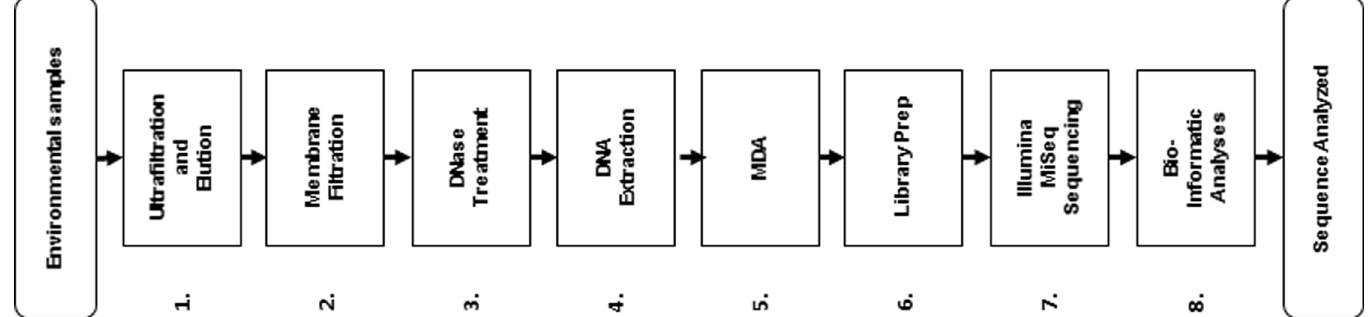
Fig 1. Schematic diagram of the specific procedures involved in processing wastewater samples for viral metagenomic analysis. MDA, multiple displacement amplification.